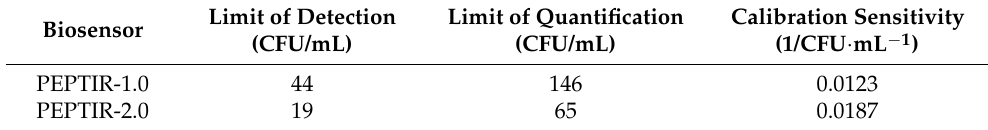
Table 3. Analytical parameters of the biosensors. Limit of Detection Biosensor (CFU/mL)